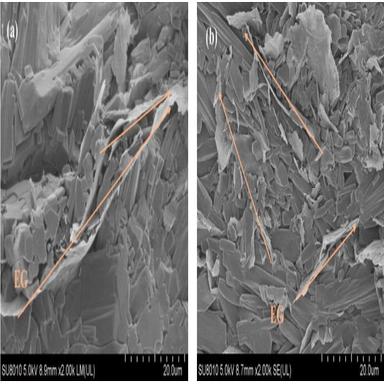
The SEM morphology of (a) CPCM1, (b) CPCM2, and (c) CPCM3.